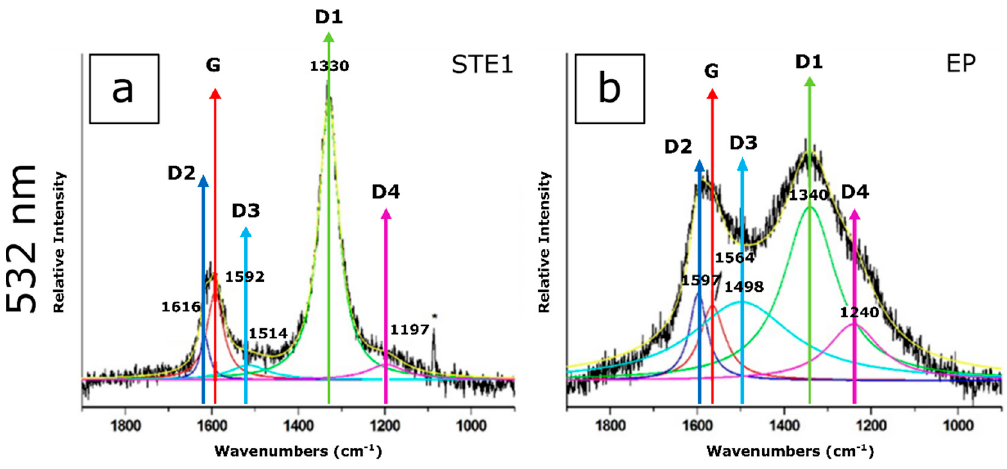
Figure 4. Typical Raman fitting results obtained by the green laser source for ( a ) STE1 and ( b ) EP samples. The first order bands of carbonaceous materials are labeled as G (graphite-like), D1, D2, D3, and D4 (disorder) vibrational modes. The Raman band indicated by the * is ascribed to calcite (CaCO 3 ), which is the main component of the